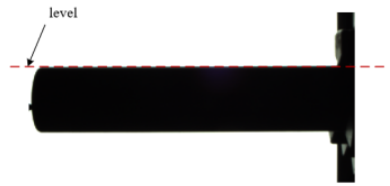
Figure 15. Workpiece image after correction.